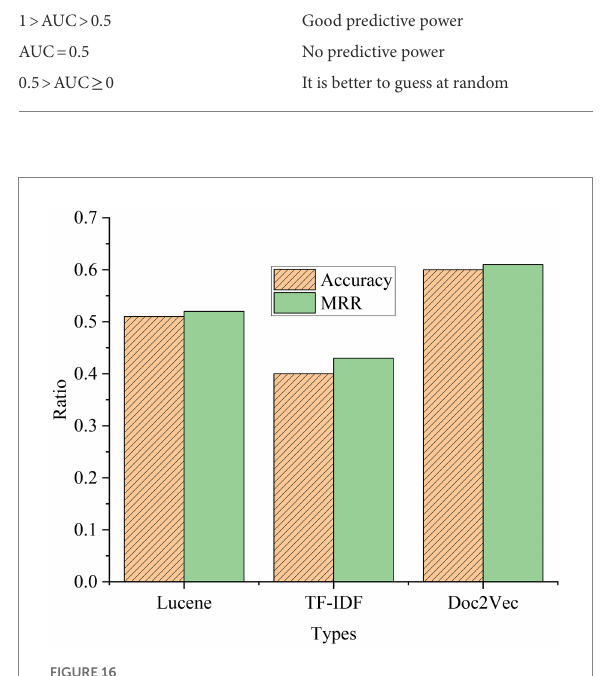
FIGURE 16 Comparison of experimental results of question-and-answer search with traditional retrieval methods.